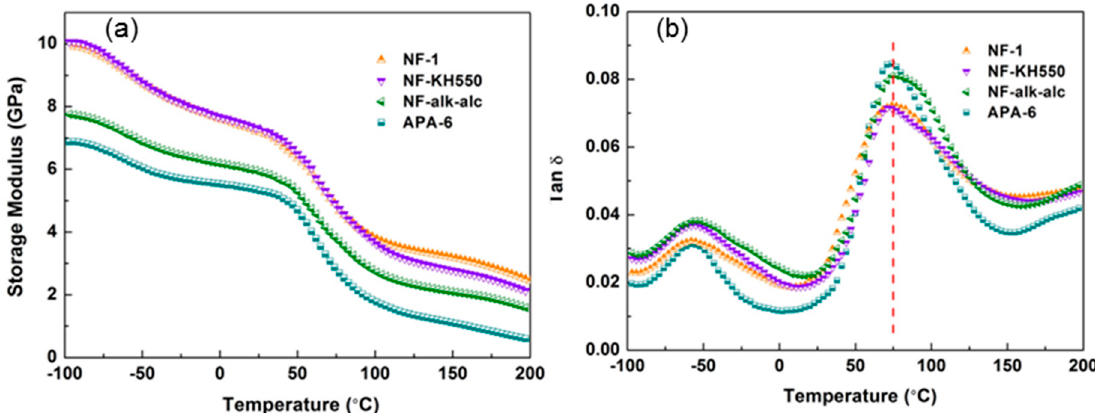
Figure 12. The dynamic modulus ( a ) and Tan δ ( b ) for different modified ramie fabrics reinforced APA-6 composites.